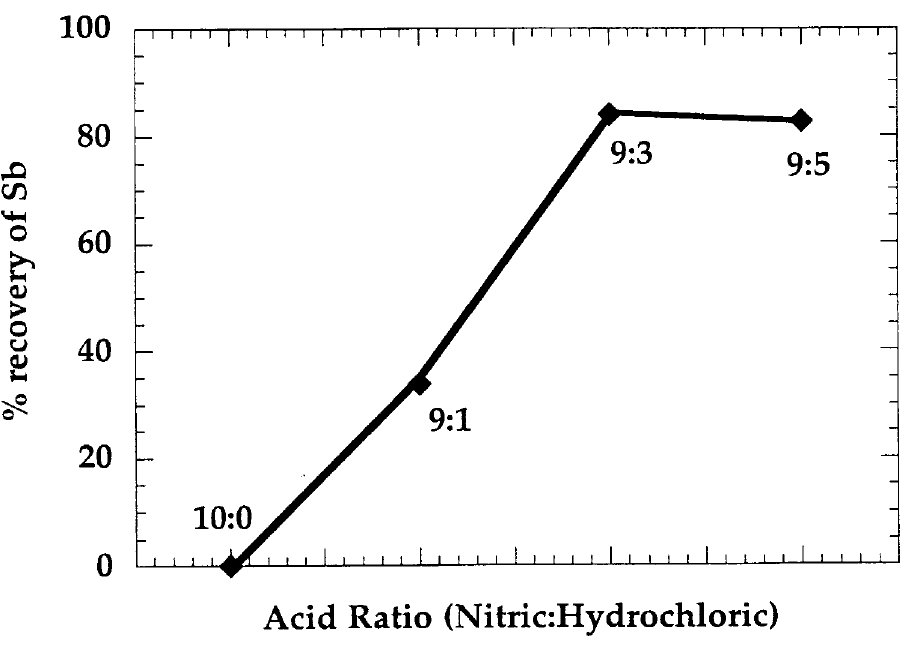
Figure taken from Refs. 6 and